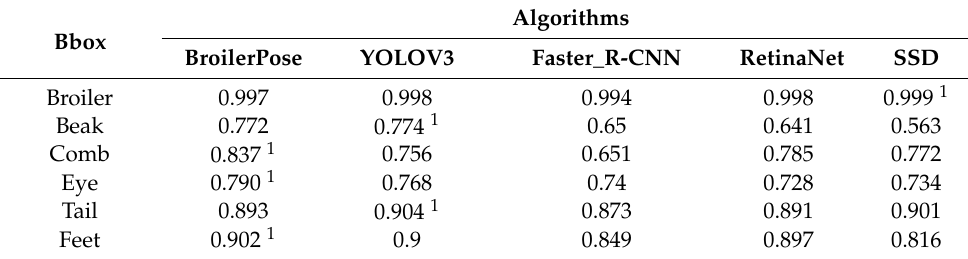
Table 2. Comparison of training effects of different algorithms.